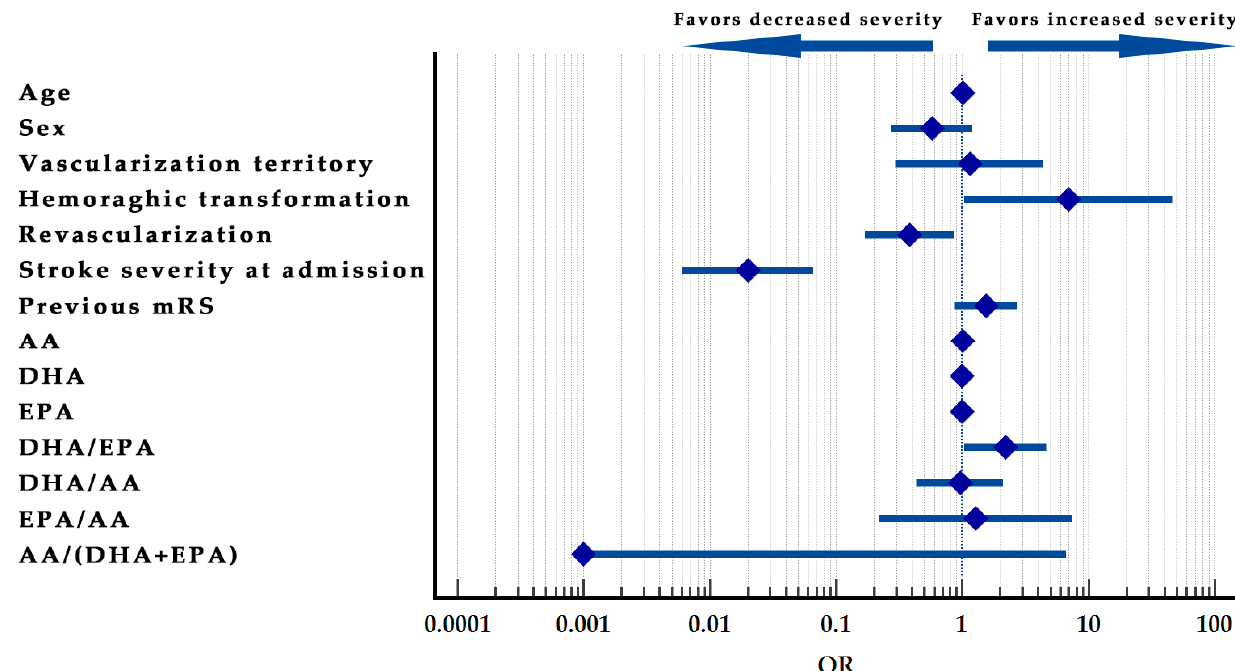
Figure 2. Stroke severity at discharge prediction model–Forest